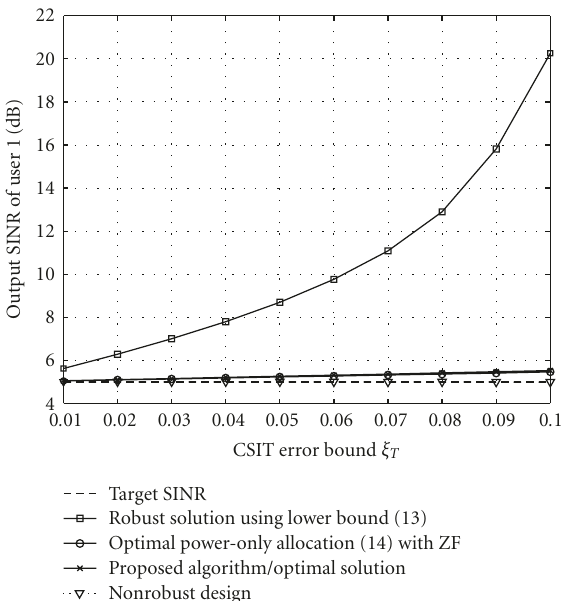
Figure 2: The user’s output SINR averaged over channel uncer- tainty for a given channel realization for various channel error bound for a 3-user (3,1) system with γ = 5 (dB).